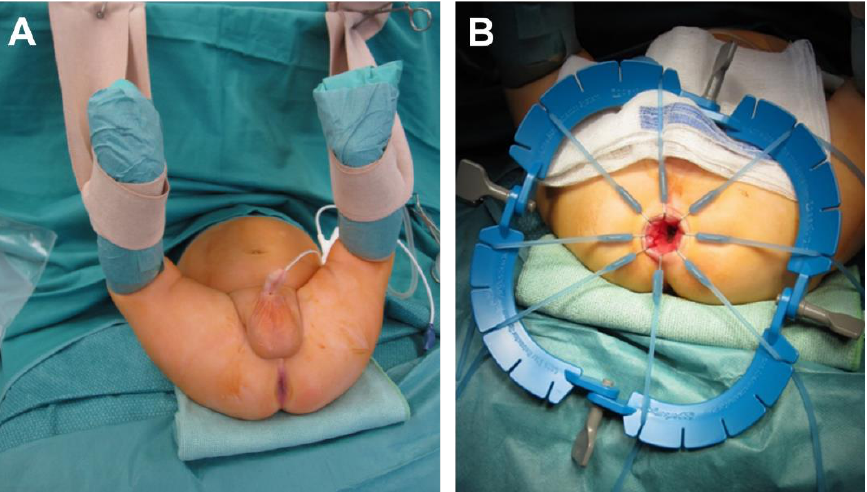
Figure 1. Setting of operation ( A ) and placement of the retractor ( B ), starting classical transanal pull-through.